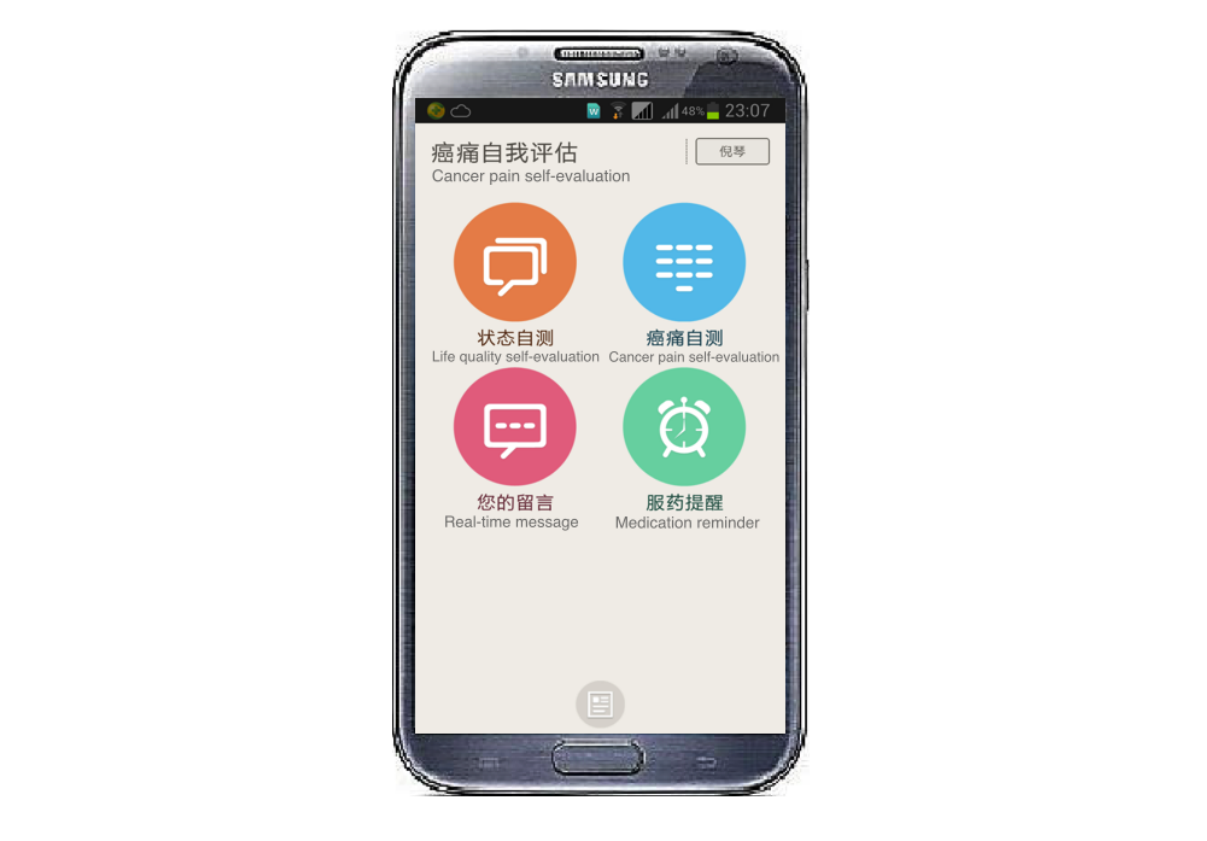
Figure 1. Screenshot of intelligent pain management system (IPMS) home screens: Life quality self-evaluation (upper left), cancer-pain self-evaluation (upper right), real-time message (lower left) and medication reminder (lower right).